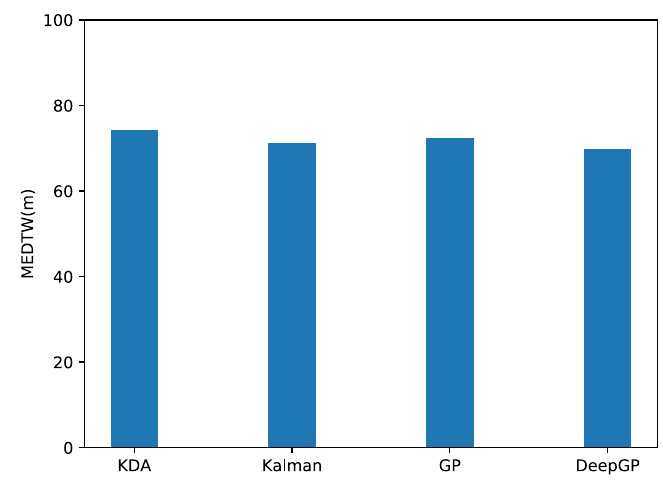
Figure 6. Experimental results for a cruise flight.